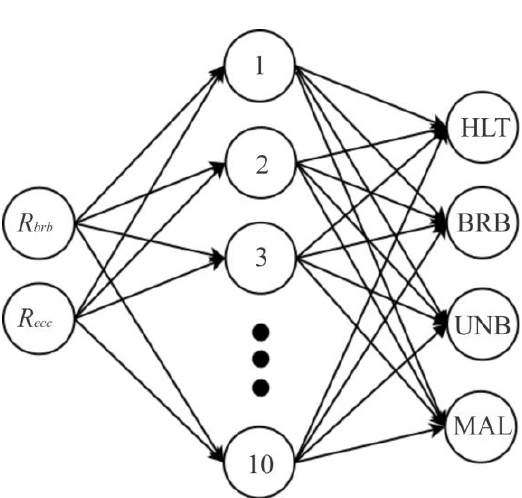
Figure 7. Proposed